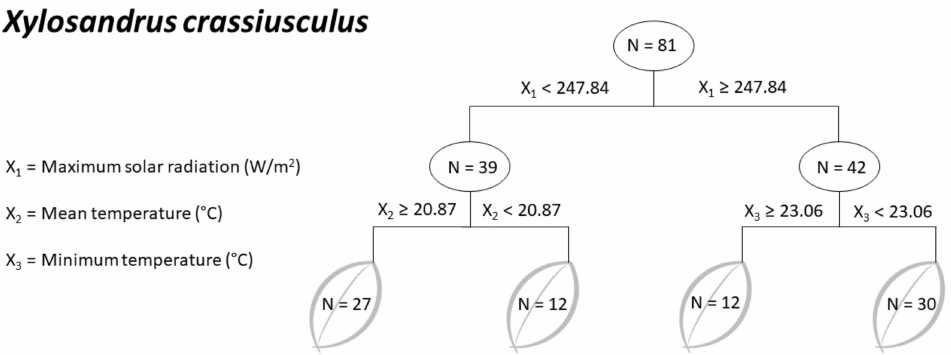
Figure 6. Decision tree schematic for Xylosandrus crassiusculus abundance using weather conditions as explanatory